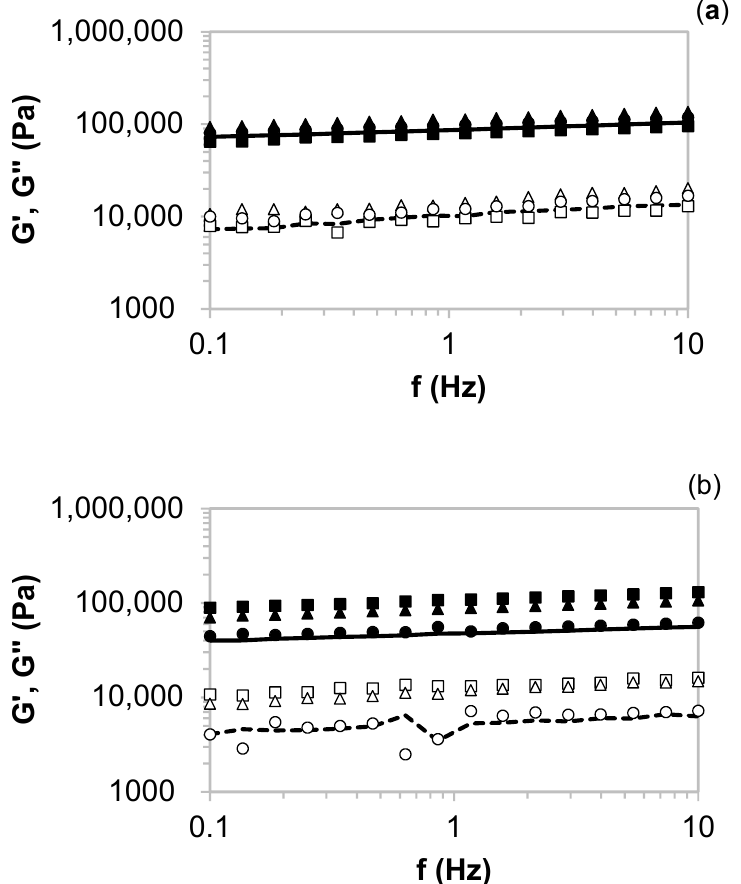
Figure 6. Oscillatory measurements of starch-based hydrogels formulated with the solid residues from artichoke bracts obtained with different techniques (( a ), conventional and ( b ), microwave) and mixed with Paulownia leaves’ autohydrolysis extracts at different ratios. Symbols: G’ (closed), G’’ (open), 25:75 (squares), 50:50 (triangles), 75:25 (circles), and 100:0 (lines).